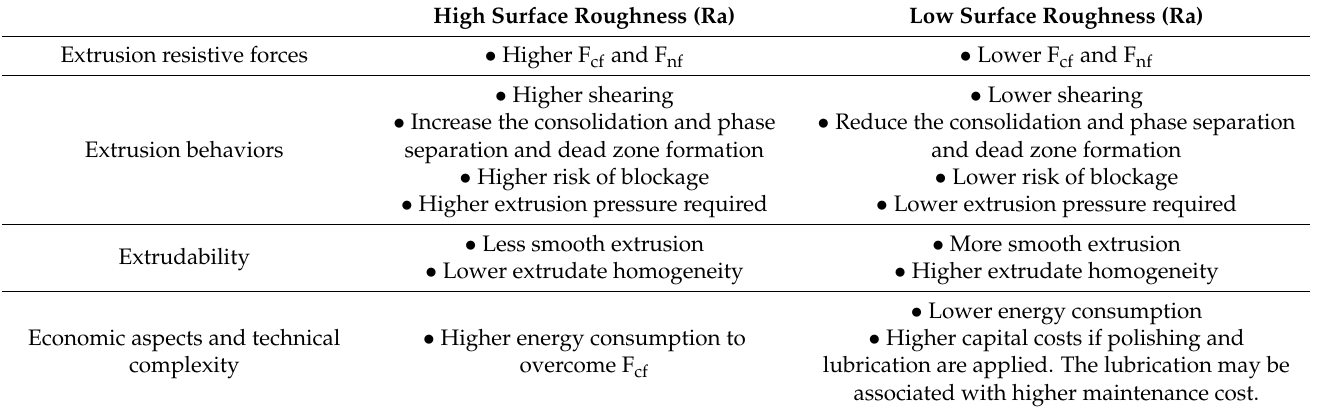
Table 3. The effects of extruder wall roughness on the extrusion forces, extrusion behaviors, ex- trudability and economic aspects and technical complexity based on the same material design and operational